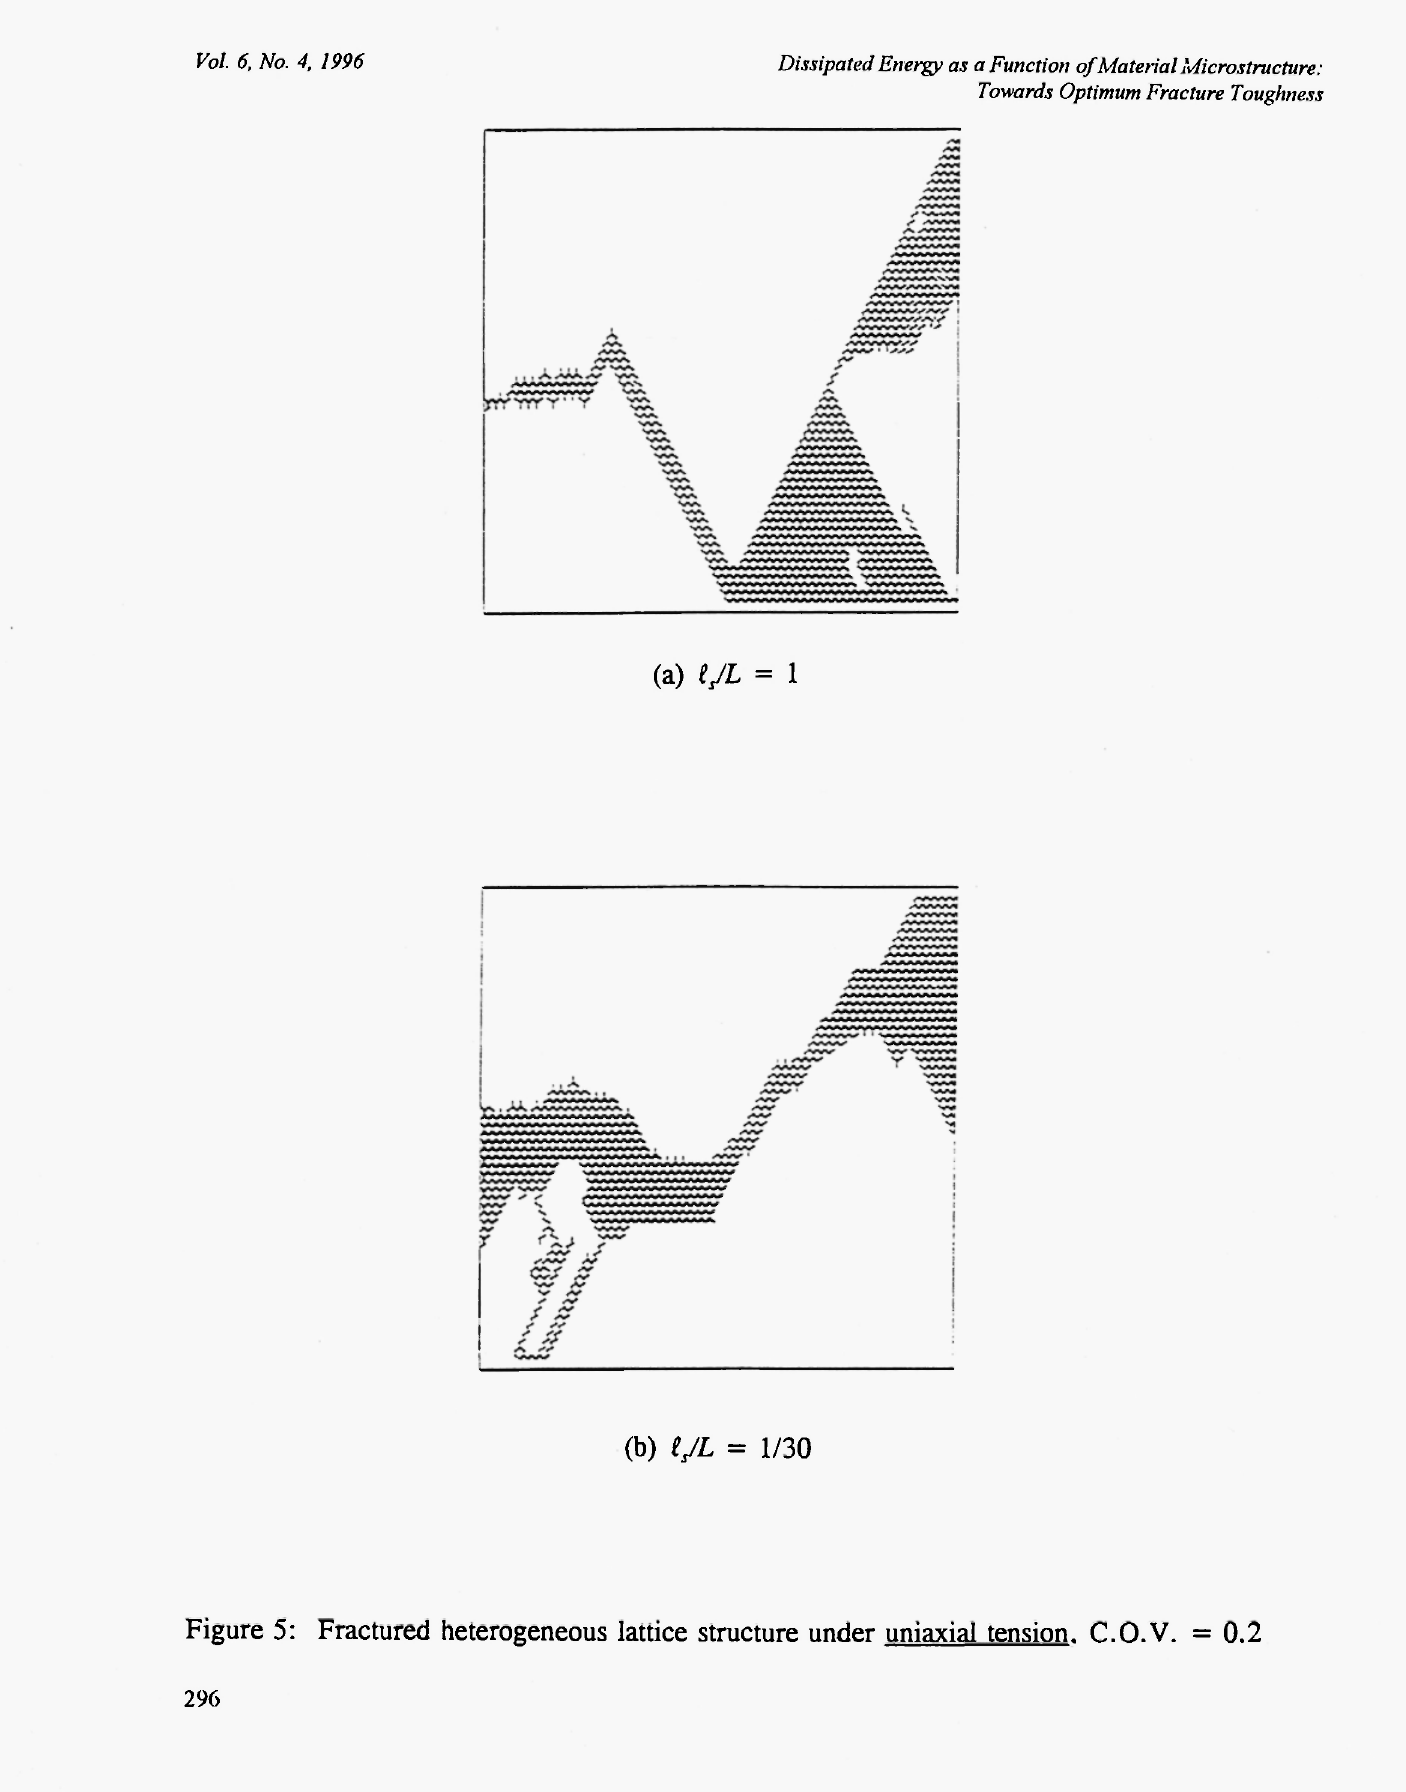
Figure 5: Fractured heterogeneous lattice structure under uniaxial tension. C.O.V. = 0.2